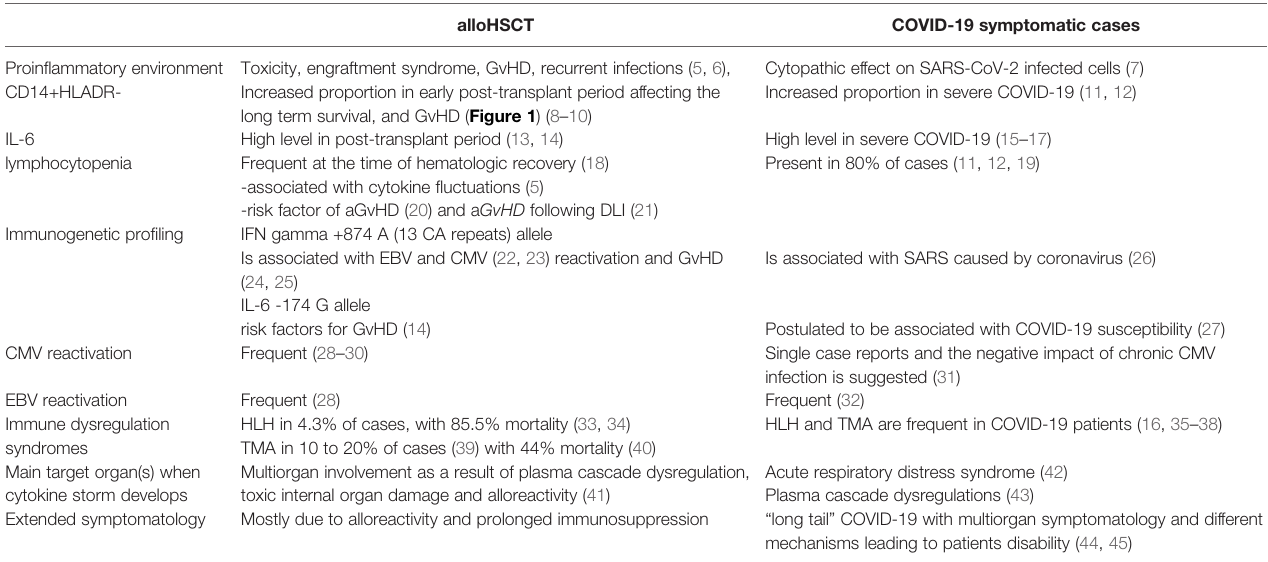
TABLE 1 | The clinical fi ndings and laboratory data registered in patients at risk of cytokine storm after alloHSCT and in those with severe COVID-19.